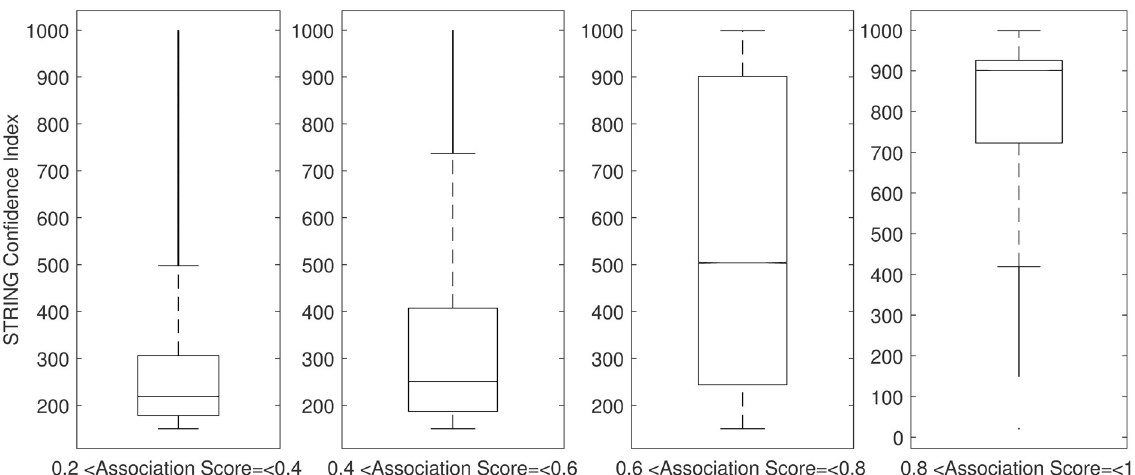
Fig 2. The predicted Association Score between two genes measures the confidence of their associations. We calculated Association Scores for all possible pairs (108,140,571 pairs) of 14,707 human genes. A total of 9,250,034 of these pairs have a known STRING confidence index. The confidence indexes of known STRING pairs are shown in the four boxplots below, grouped by their predicted Association Scores. As the predicted Association Score increases (left to right), the average STRING confidence index also increases (low to high).